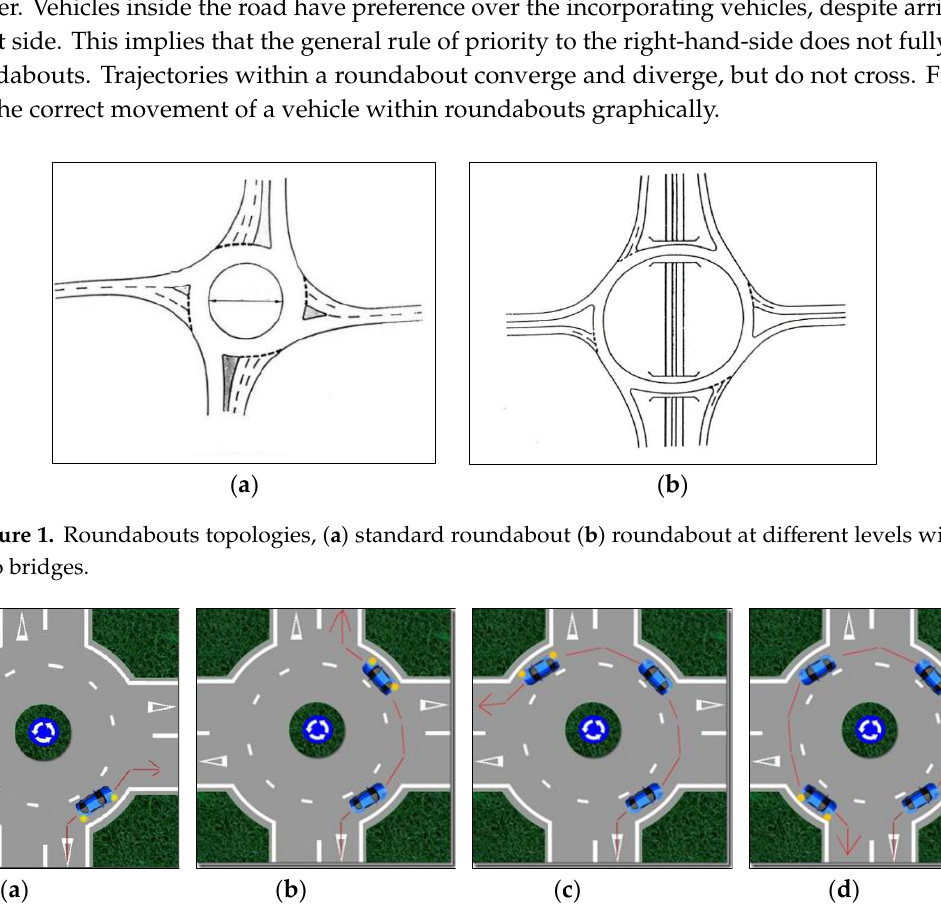
Figure 2. Correct movement of a vehicle in a roundabout: ( a ) first exit, ( b ) second exit, ( c ) third exit, ( d ) fourth exit.